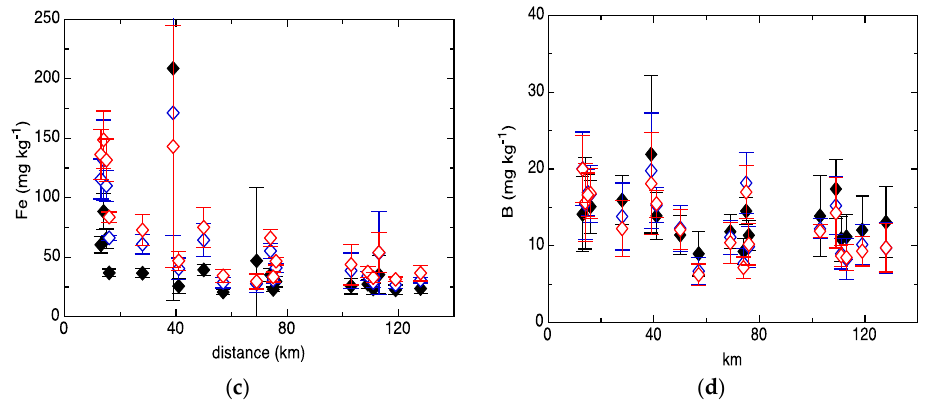
Figure 3. ( a ) Calcium; ( b ) zinc; ( c ) iron; and ( d ) boron versus distance to the major emission sources in the Athabasca Oil Sands Region (AOSR); black diamonds = current annual growth (CAG), blue diamonds = year 1, red diamonds = year 2 needles.